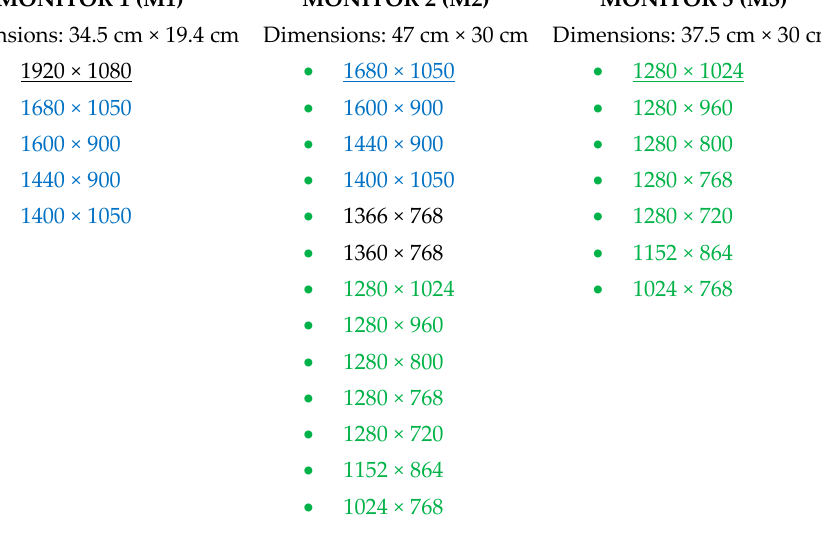
Figure 4. Example of targets’ locations.